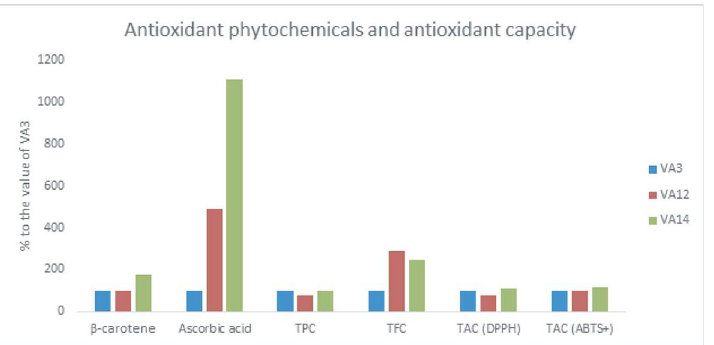
Fig 5. Response of antioxidant phytochemicals and antioxidant activities (% to the value of VA3) in three